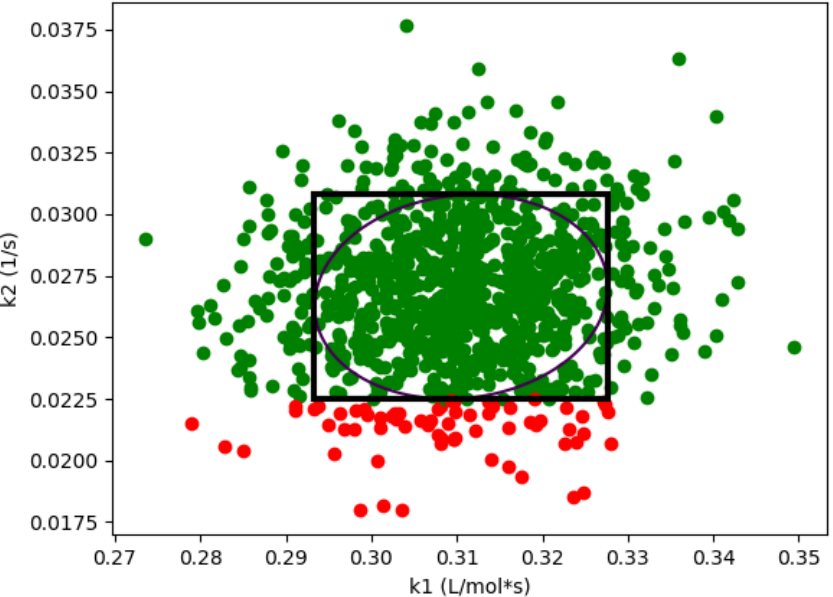
Figure 3. For case study 1, flexibility index produces a more conservative region than Algorithm 1. Green points are feasible, red points are not feasible. This figure demonstrates both ellipsoid and hyperrectangle regions are more conservative at τ = 400.0 and R =